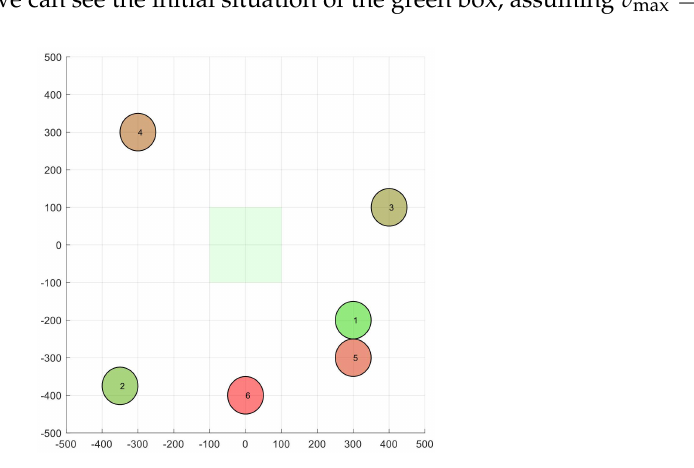
Figure 2. Example scenario. Circles represent the position of 6 UAVs. The green box represents the initial valid velocity space for node